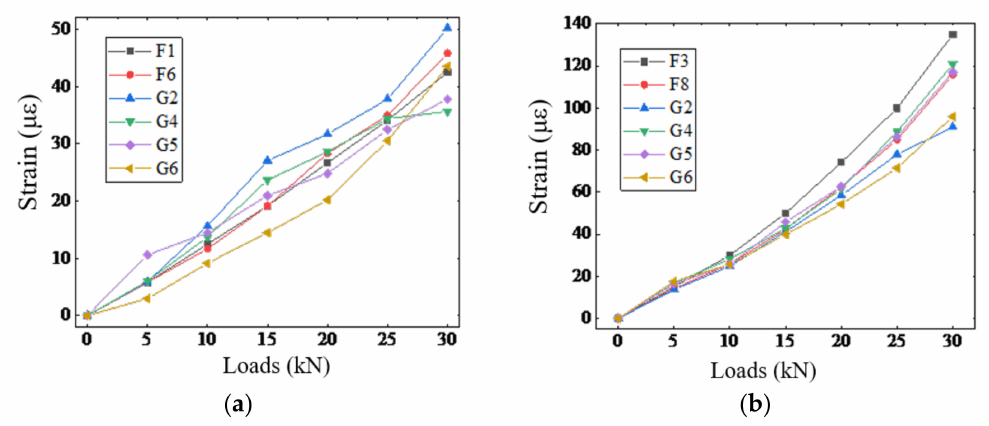
Figure 20. Comparison of strain measurements from DPP-BOTDA and FBG ( a ) at locations of F1 and F6 ( b ) at locations of F3 and